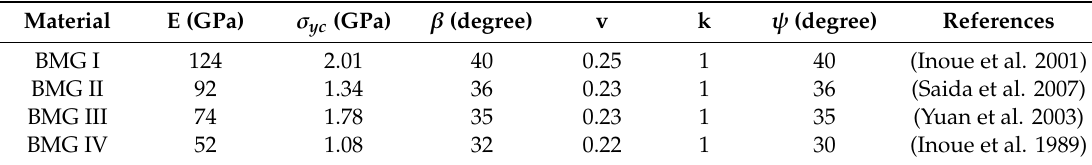
Table 4. Bulk metallic glass material properties.